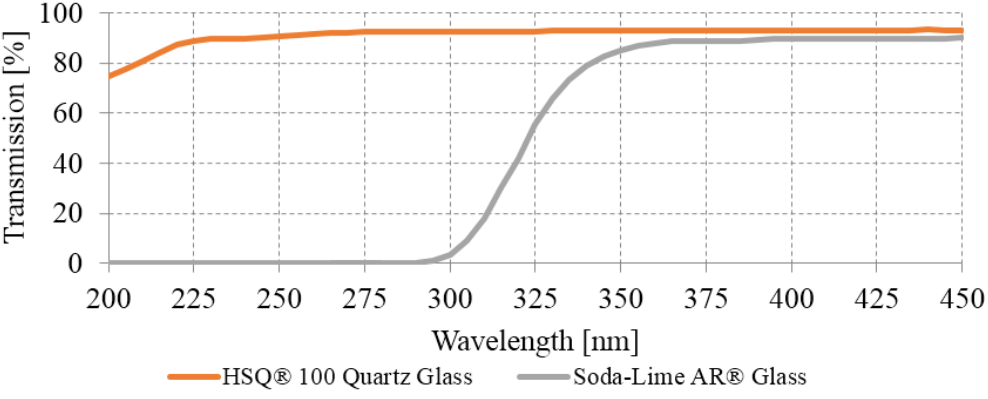
Figure 4. Transmission of HSQ ® 100 quartz glass (red) (92% at 280 nm) and soda-lime glass (green) (2% at 280 nm) with a thickness of 1 mm between 200 and 450 nm; reference: